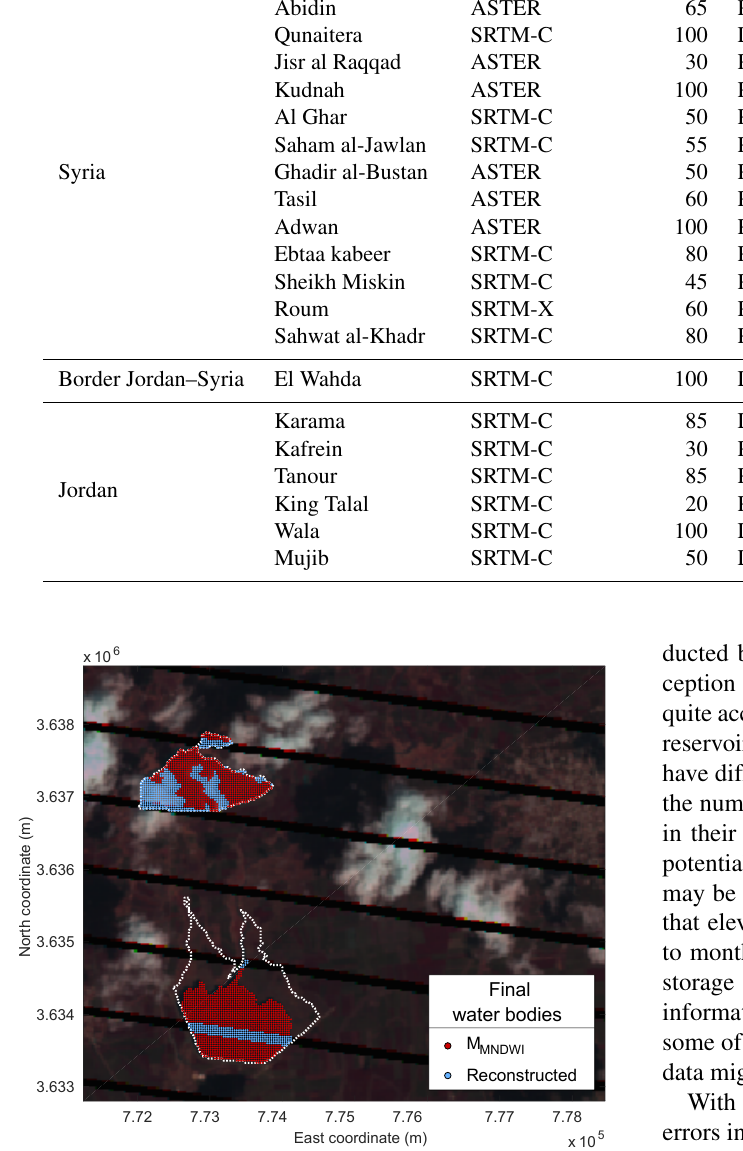
Figure 9. SWIR-R-G image. Final water bodies as obtained af- ter the 2-D enhancement and the 3-D reconstruction applied to the Landsat 7 image (174/37) taken on 30 March 2010 (same as Fig. 4). Coordinates are expressed in CRS WGS 84/UTM zone